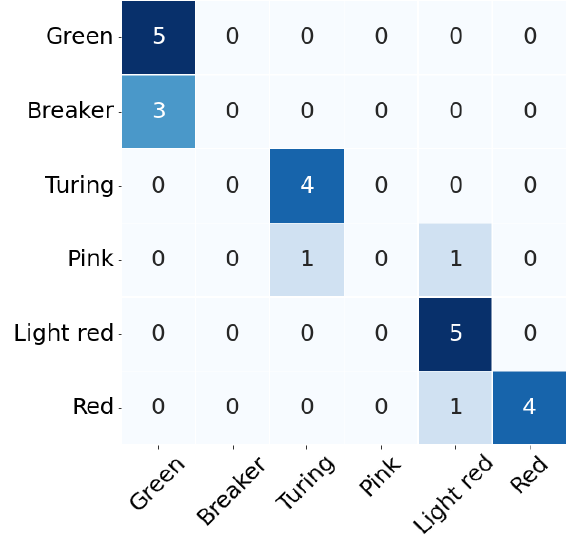
Figure 8. The confusion matrices of field test with VIS